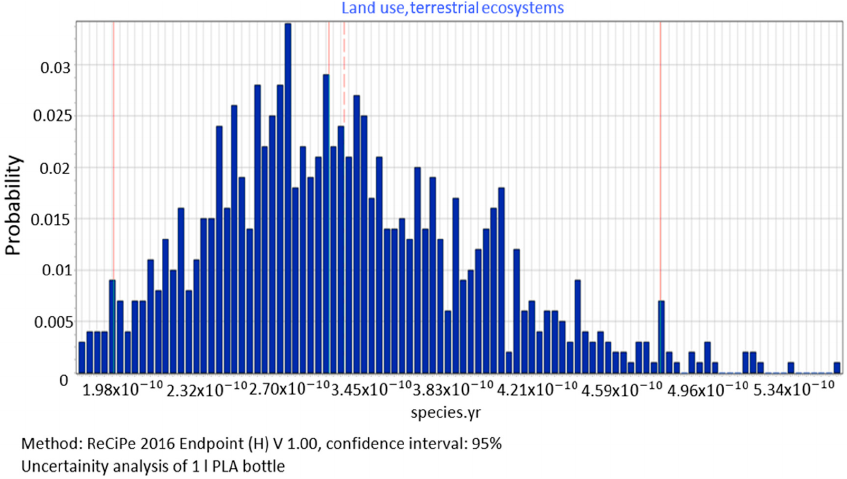
Figure 12. Results of the uncertainty analysis for the category of land use and its impact on the ecosystem quality.